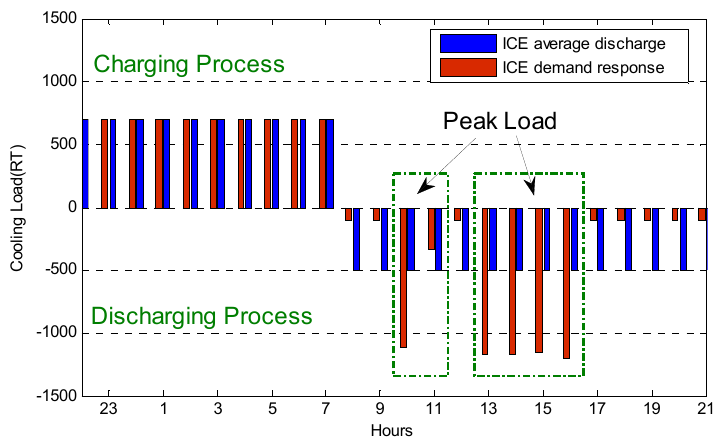
Figure 8. Operating types of ice storage tank in summer.